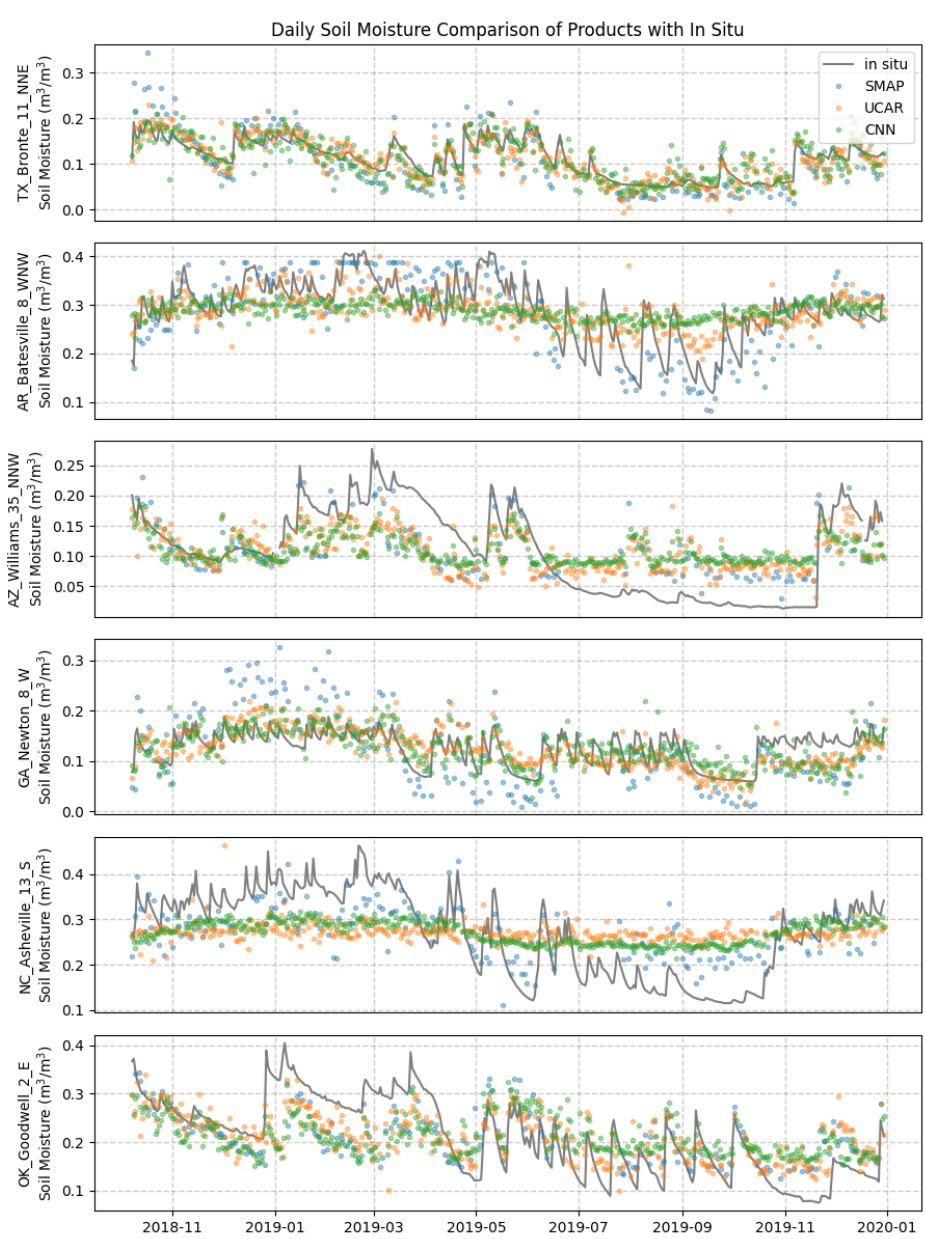
Figure 18. Comparison of the soil moisture measurements from six locations in the southern United States (solid lines), and the predictions from SMAP (blue), UCAR (orange), and the CNN (green), from daily averages 36 km around the site. In-situ values are from the USCRN 5 cm depth soil moisture product. Note that the bias between each product and the in-situ measurement was